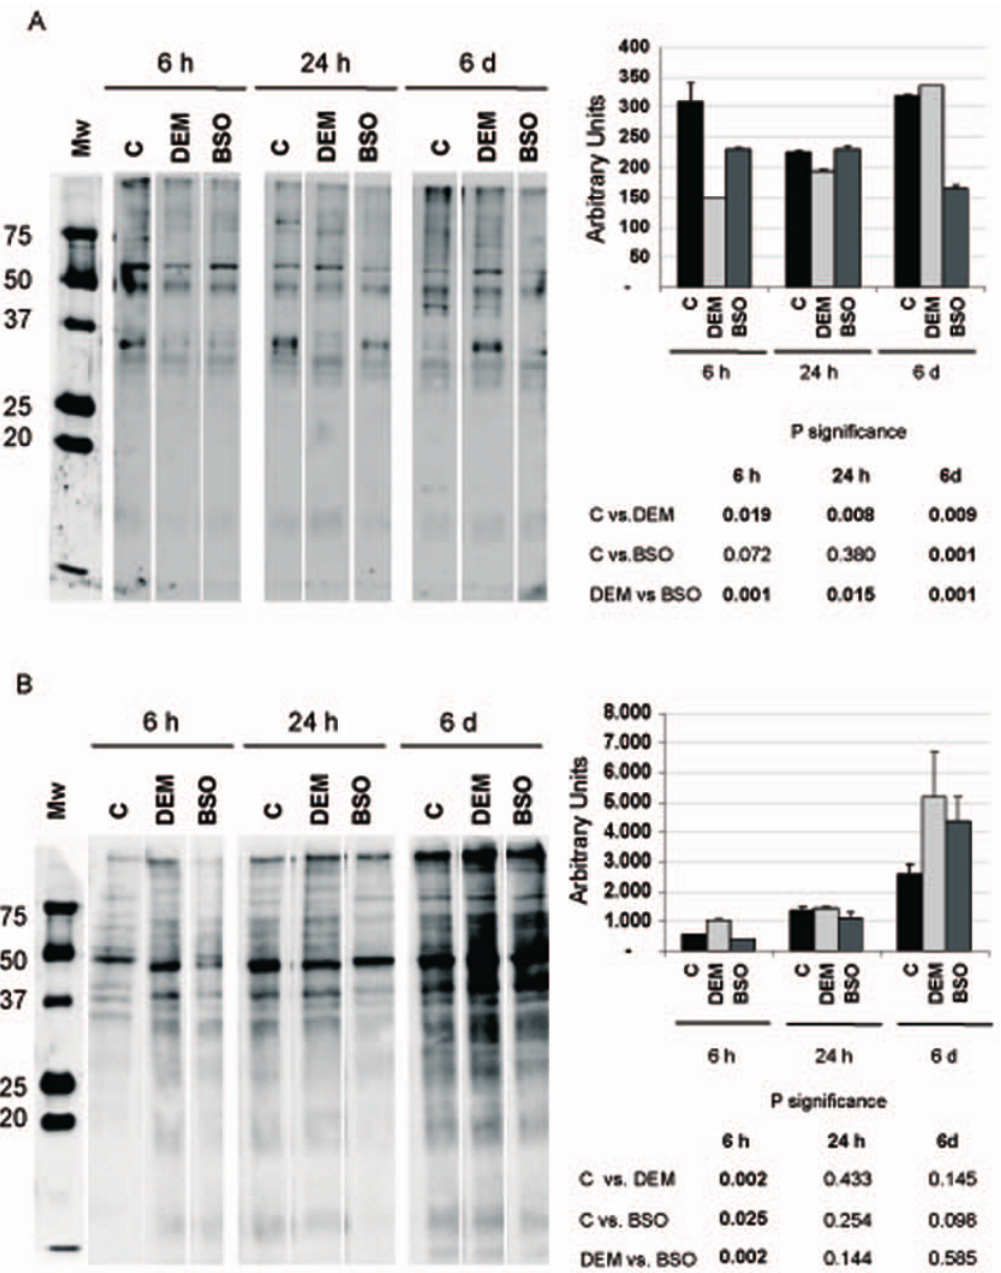
Figure 8. The pattern of overall S-glutathionylated and oxidized nuclear proteins induced by the two GSH depleting agents at 6 h, 24 h and 6 days in culture. A.- Glutathionylated proteins: equal amount of nuclear extracts were loaded and separated by a 12% SDS gel under non- reducing conditions. S-glutathionylated proteins were detected by Western blot using anti-glutathione monoclonal antibody. B.- Oxidized proteins: equal amounts of nuclear extracts were derivatized and separated by electrophoresis in an acrilamide gel. Western blotting and subsequent immunodetection of carbonylated proteins were performed according to the protocol recommended by the manufacturer (see material and methods). Right panels shows the densitometry results for the level of glutathyolation and oxidation of nuclear proteins, respectively [Mean 6 SD